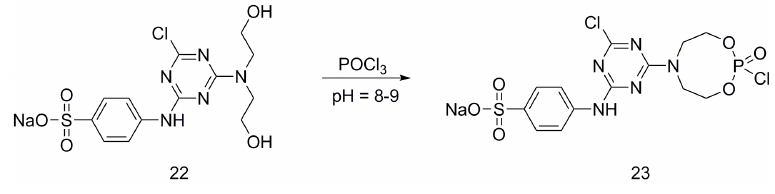
Figure 15. Representative synthesis of monomer ( 23 ).